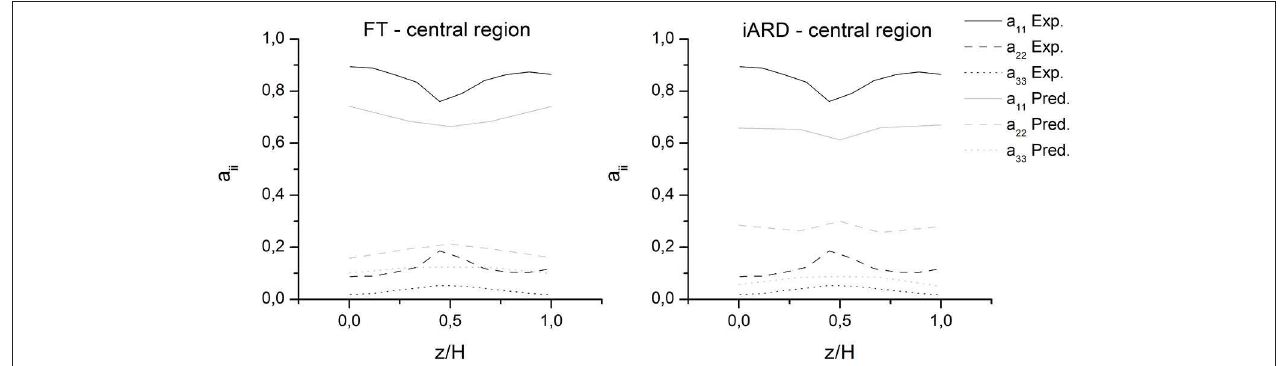
Table 1 . The following observations arise from the analysis of the